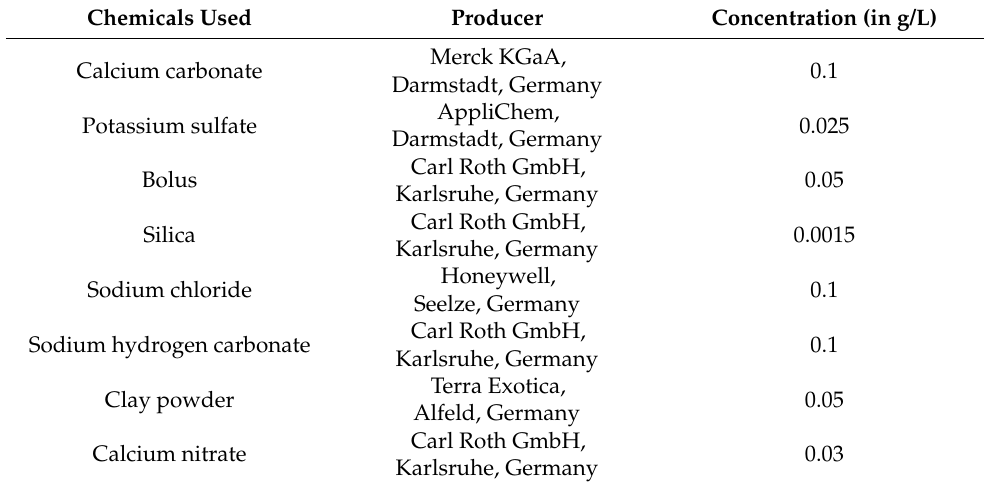
Table 1. Composition of the model suspension.